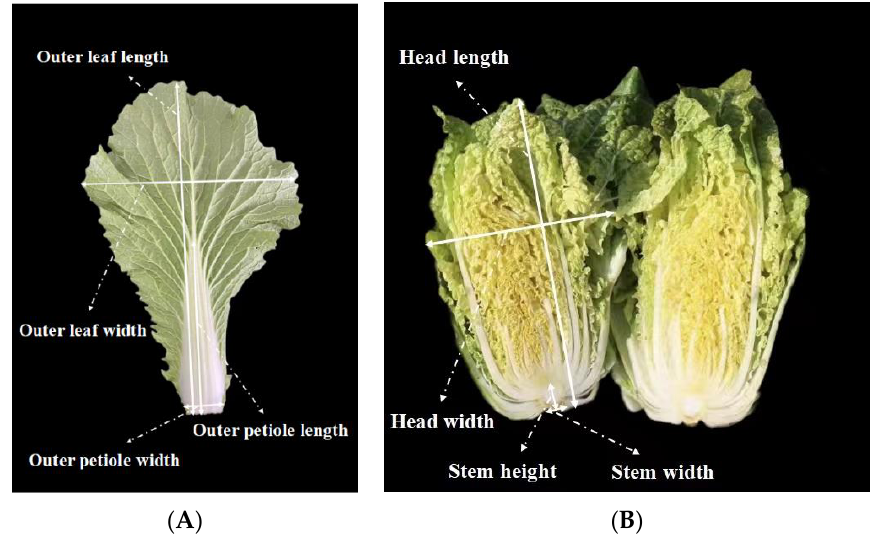
Figure 2. ( A ) The measurement standard of outer-leaf length, outer-leaf width, outer-petiole length, and outer-petiole width. ( B ) The measurement standard of head length, head width, Stem height, and Stem width.